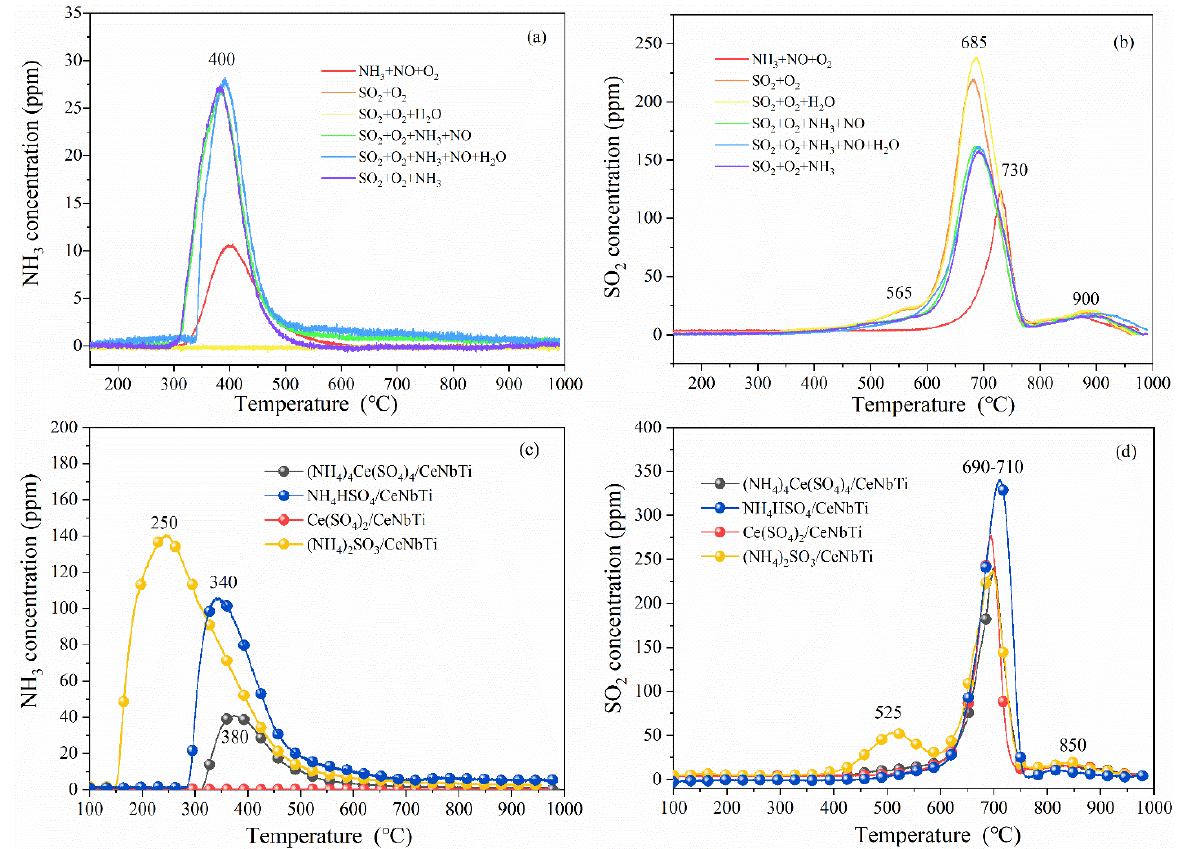
Figure 2. TPD curves of ( a , c ) NH 3 and ( b , d ) SO 2 over the treated ( a , b ) and deposited ( c , d ) catalysts. Table 1. Amounts of NH 3 and SO 2 that were released from the treated catalysts during the TPD tests.